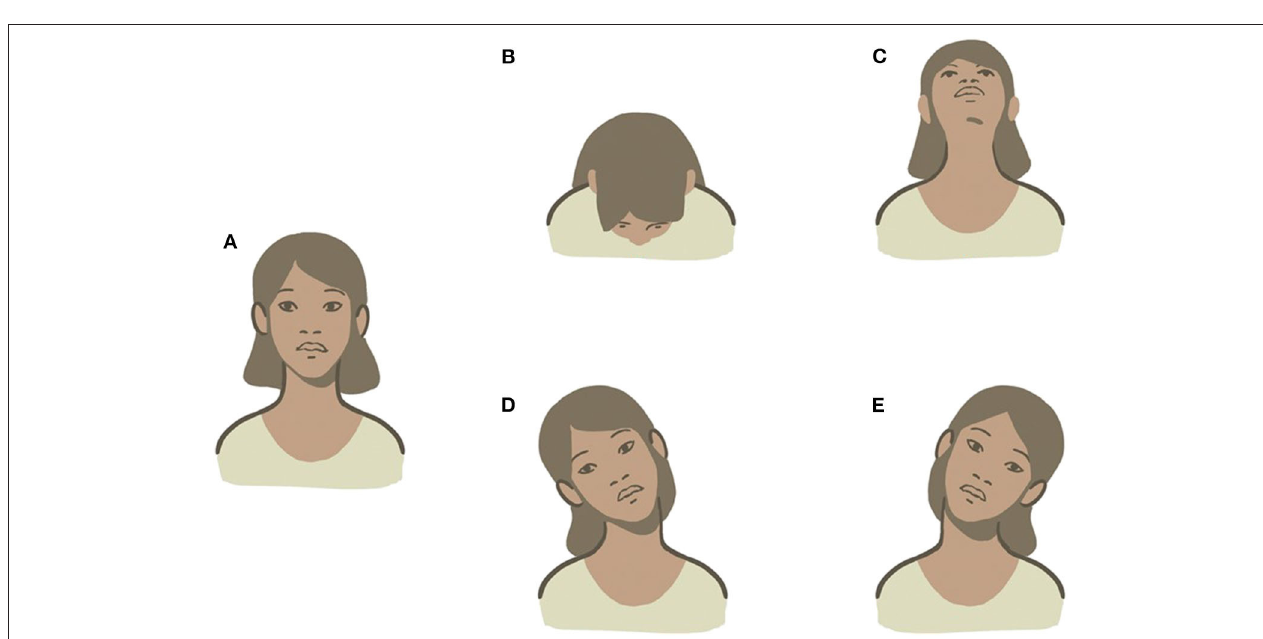
FIGURE 2 | UBP for BPPV-LSC. (A) Detection of pseudo-spontaneous nystagmus (PSN). (B) Head pitch test (HPT) with forward head bending. (C) HPT with backward head bending. (D) Upright head roll test (UHRT) with rightward head tilting. (E) UHRT with leftward head